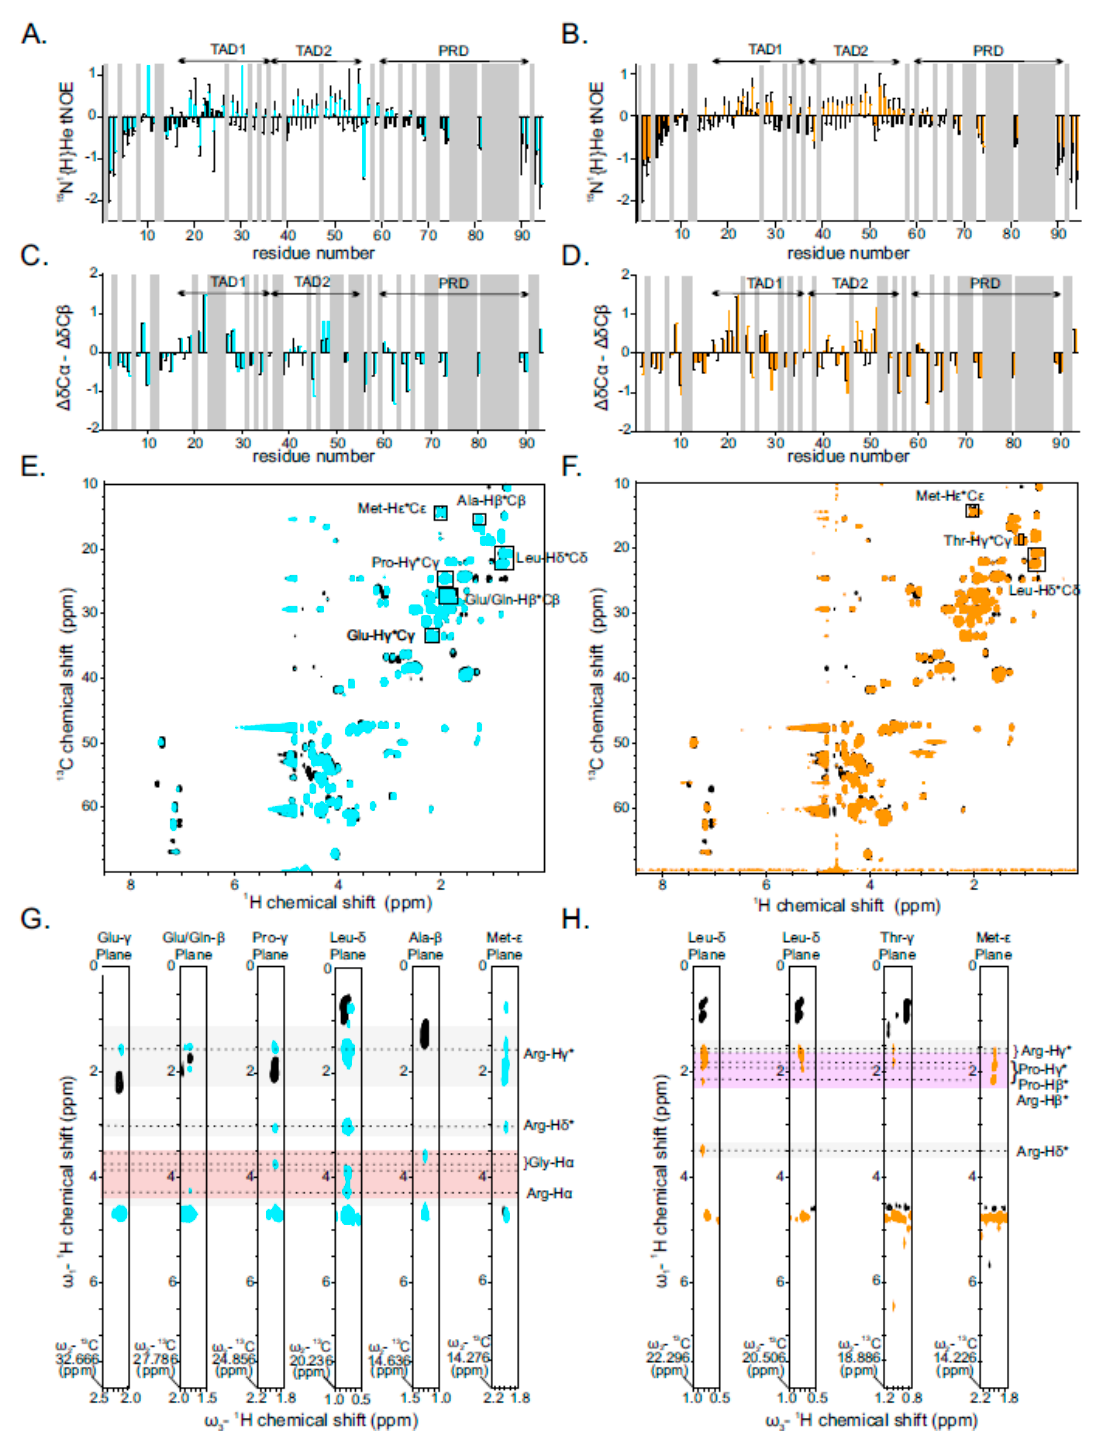
Figure 3. Binding of PR25/GR25 to p53 1 − 94 increases its rigidity and α -helical secondary structure propensity via electro- static and/or hydrophobic interactions. ( A , B ) 15 N{ 1 H} heteronuclear NOEs are plotted for p53 1 − 94 residues in the absence (black) or presence of GR25 (cyan in A ) or PR25 (orange in B ), respectively. Error bars for heteronuclear NOE values were derived from error propagation calculation using standard deviation of 10 arbitrarily chosen noise peaks in saturated and unsaturated spectra; ( C , D ) Plot of difference between the secondary 13 C chemical shifts of the C α (noted as Δδ C α ) and the C β (noted as Δδ C β ) nuclei of p53 1 − 94 in the absence (black) or presence of GR25 (cyan in C ) and PR25 (orange in D ), re- spectively. Secondary chemical shifts were obtained by subtracting the random coil chemical shifts (predicted by ncIDP) from observed chemical shifts. Differences between the secondary chemical shift deviations ( Δδ C α - Δδ C β ) were plotted against the amino acid residue numbers, taking into account next neighbor effects; ( E , F ) 1 H- 13 C HSQC spectra of 13 C-la- beled p53 1 − 94 in the absence (black) or presence of either GR25 (cyan in E ) or PR25 (orange in F ). Residues with NOE cross peaks are indicated by black squares; ( G ) Slices from 1 H 1 H planes of a 3D 13 C/ 15 N filtered, 13 C-edited NOESY-HSQC spec- trum recorded on 13 C, 15 N-labelled p53 1 − 94 in the presence of 1.33 stoichiometric equivalents of unlabeled GR25. NOESY cross peaks are shown in cyan. Representative two-dimensional planes are shown for different 13 C chemical shifts and